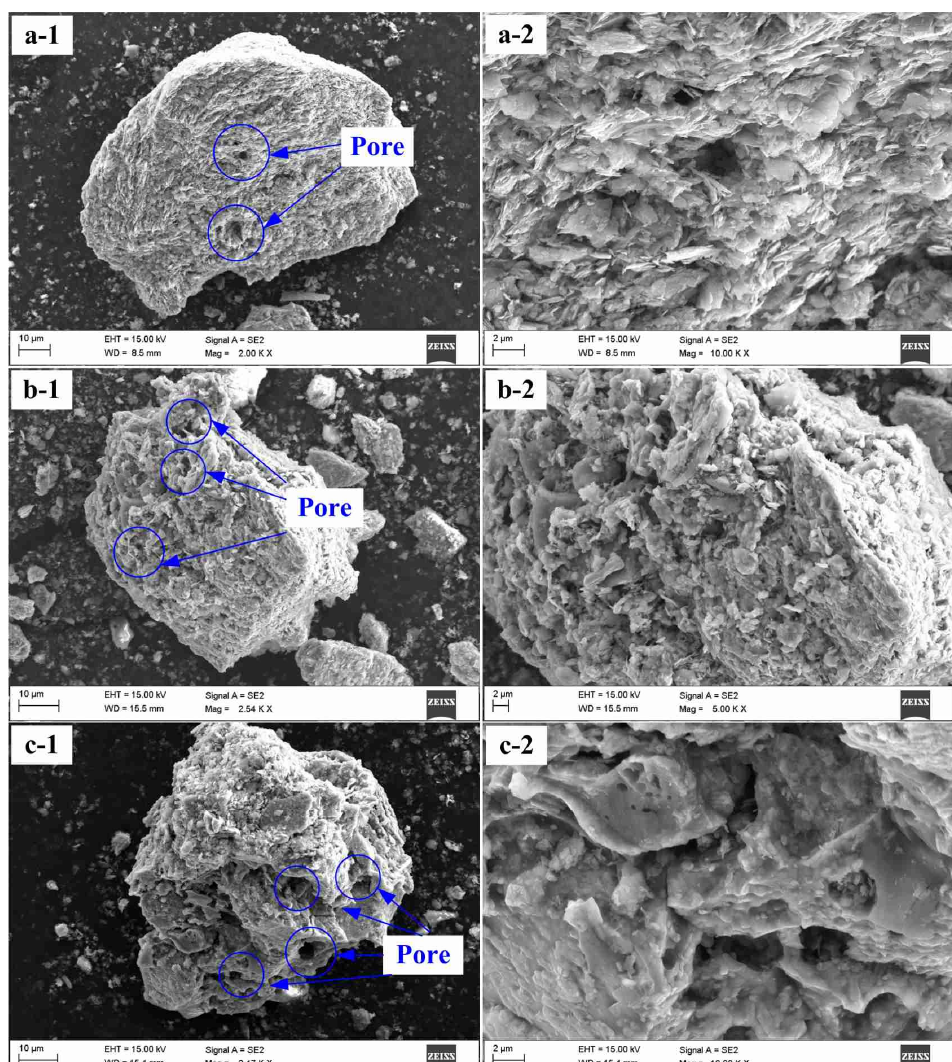
Figure 11. SEM images of materials with different roasting times, with roasting temperature of 650 °C, at a CO concentration of 35%: ( a-1 , a-2 ) 3 min, ( b-1 , b-2 ) 4 min, ( c-1 , c-2 ) 5 min.